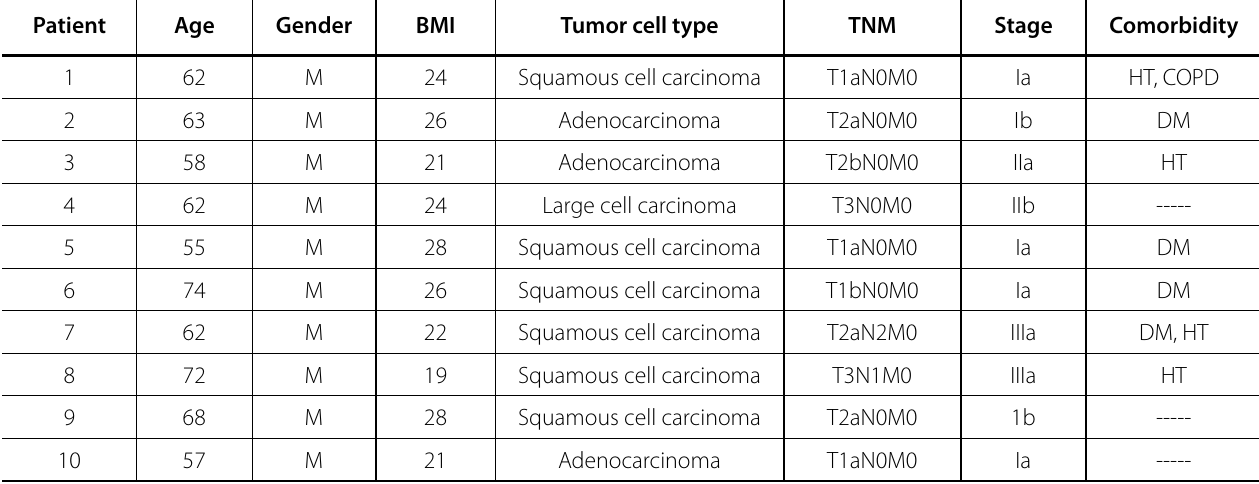
Table 1 . Patient demographics.